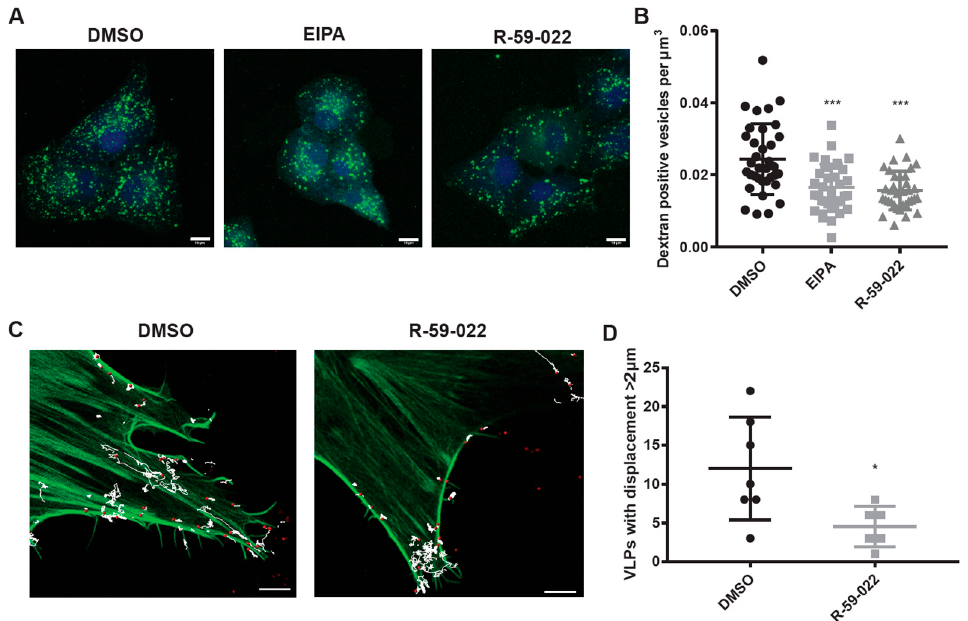
Figure 4. R-59-022 inhibits macropinocytosis in Vero cells. ( A ) Vero cells were pre-treated with R-59-022 (5 µ M), EIPA (30 µ M), or vehicle for 30 min followed by addition of high molecular weight fluorescein dextran and incubation at 37 ◦ C for another 30 min. Cells were stained with Cell Tracker Blue CMAC fluorescent dye, which was added concomitantly with the fluorescent dextran. Cells were fixed and imaged with a LSM 800 confocal microscope (Zeiss). Images are displayed as maximum intensity z-projections, bar = 10 µ m; ( B ) Number of dextran-positive puncta per cell volume ( µ m 3 ) was determined using the Imaris software (Bitplane). ( C ) GFP-Utrophin transfected Vero cells were pre-treated with R-59-022 (5 µ M) or vehicle for at least 30 min. The cells were then placed in an environmental chamber (37 ◦ C, 5% CO 2 ) and mCherry EBOV VLPs added. Immediately after VLP addition, cells were imaged with a LSM 880 confocal microscopy (Zeiss) using AiryScan FAST on a single z plane. Images were analyzed using tracking algorithms on Imaris software (Bitplane). Each track represents the movement of VLPs over time. Bar = 5 µ m; ( D ) Track length and displacement were measured (per VLP) and the number of VLPs with a displacement greater than 2 µ M were counted per time lapse image. Data are representative of 3 independent experiments. * p < 0.05, p < 0.01, *** p <